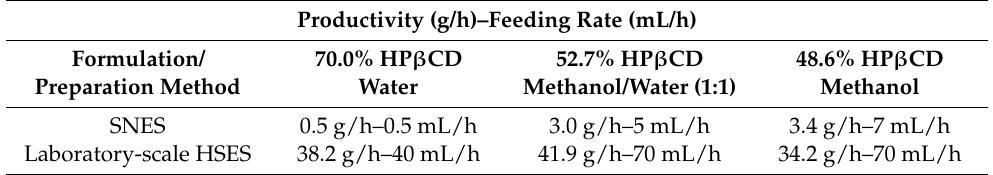
Table 1. Comparison of the productivity achieved using SNES and HSES equipment with HP β CD solutions. Productivity was calculated from the feeding rate, solution density, and HP β CD content. The density of the solutions containing 70.0% HP β CD in water, 52.7% HP β CD in methanol/water (1:1), and 48.6% HP β CD in methanol was 1.36 g/mL, 1.14 g/mL, and 1.01 g/mL respectively.